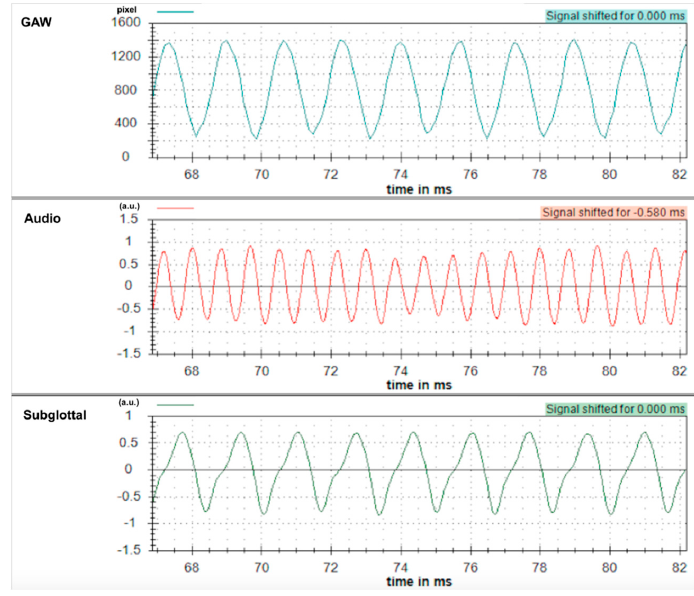
Figure 4. GAW, audio signal, subglottal frequencies in periodic vocal fold vibrations.